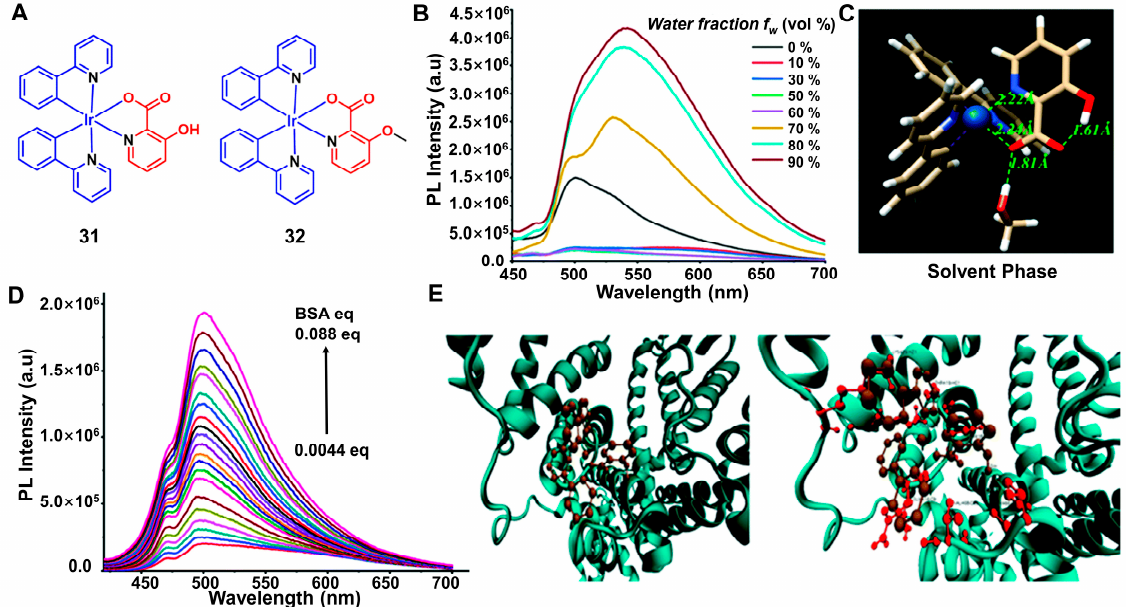
Figure 14. (A) The chemical structures of complexes 31 and 32 . ( B ) PL spectrum of 31 in MeOH with different water concentration. ( C ) DFT optimized structure of 31 in MeOH. ( D ) PL intensity of 31 (1 × 10 − 5 M) with gradually increasing BSA. ( E ) Alpha helices are binding partners of the ligand in the binding pocket and hydrogen bonding interactions of 31 with the residues of the proteins. Reprinted with permission from [80] , copyright 2020, Royal Society of Chemistry.